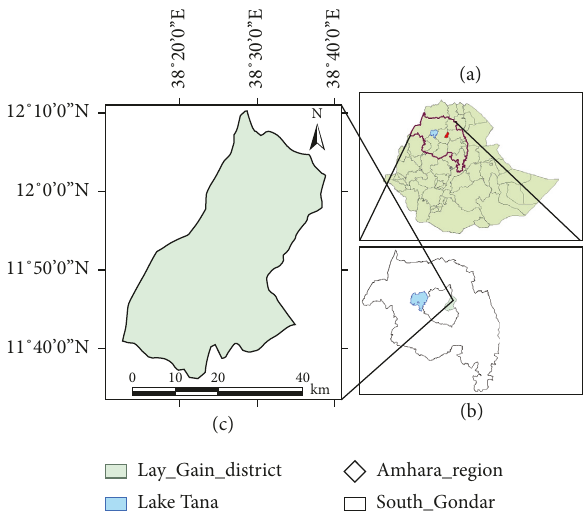
Figure 1: Map of the study areas: (a) Ethiopia, (b) Amhara region, and (c) Study